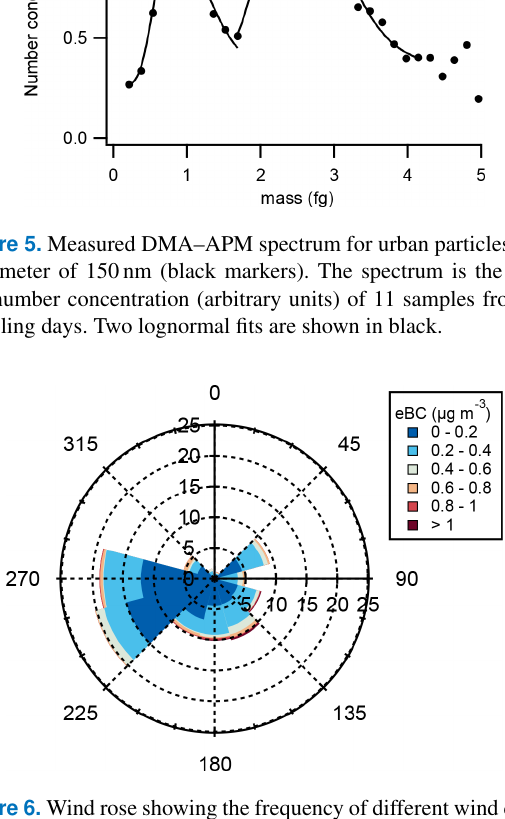
Figure 6. Wind rose showing the frequency of different wind direc- tions (30 ◦ resolution) during the rural campaign and corresponding concentrations of